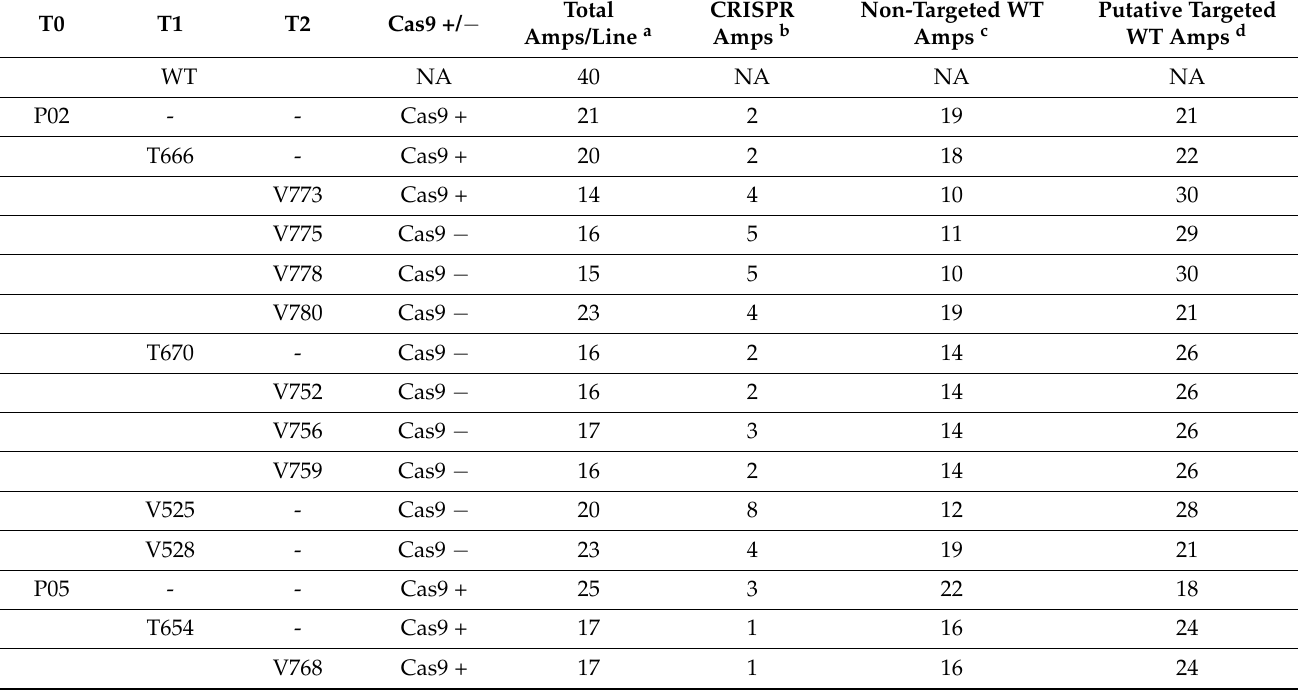
Table 4. Total number of Amps (frequency > 0.3%) detected for each T0 line and their T1 and T2 offspring lines from the tetraploid DP genotype. We also represented the number of CRISPR Amps, non-targeted WT Amps, and putative targeted WT Amps per line. The number of Amps for the WT has been calculated as the mean of all WT lines.